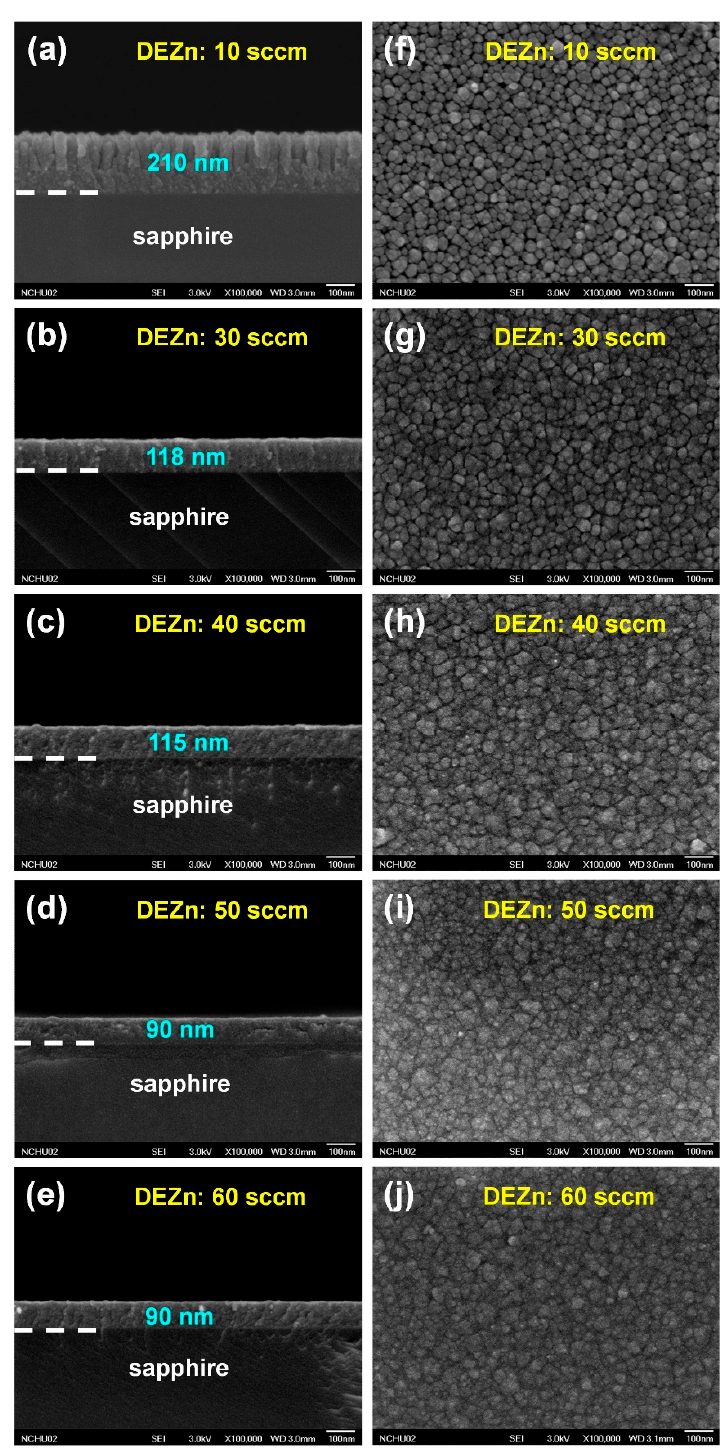
Figure 18. ( a − j ) Cross-sectional and corresponding plan-view images of SEM for ZnGa 2 O 4 films deposited at the DEZn flow rates of 10, 30, 40, 50, and 60 sccm [76] (with copyright permission from American Chemical Society, 2020).